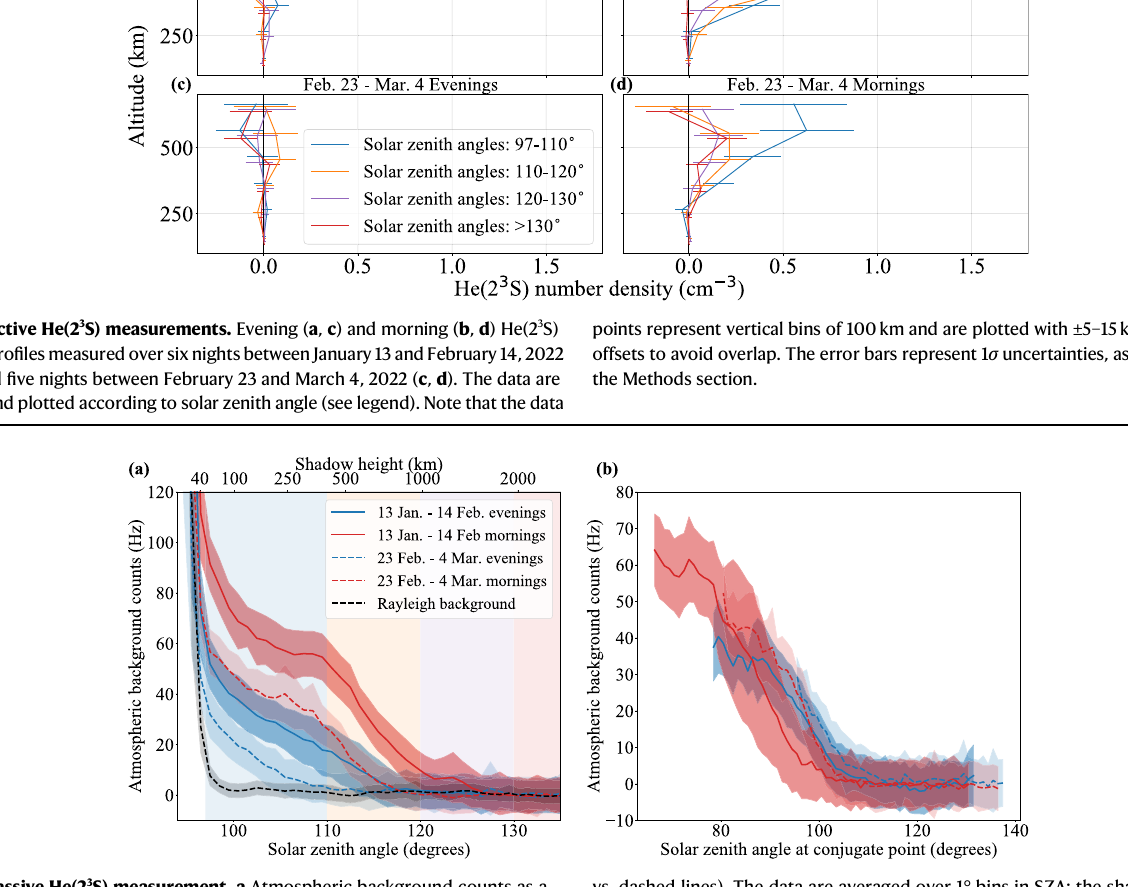
vs. dashed lines). The data are averaged over 1° bins in SZA; the shaded regions abouteachline indicate the standard deviationwithineachbin. Thedashed black line shows the contribution due to Rayleigh scattering in the lower atmosphere, as measured at a wavelength 70 pm off the He(2 3 S) line; this accounts for the rapid increase at SZA<97°. The shaded bands in SZA indicate the binning inter- vals used in the active measurement (see Fig. 2). b Atmospheric background counts as a function of SZA at the geomagnetic conjugate point to the mea- surement location.